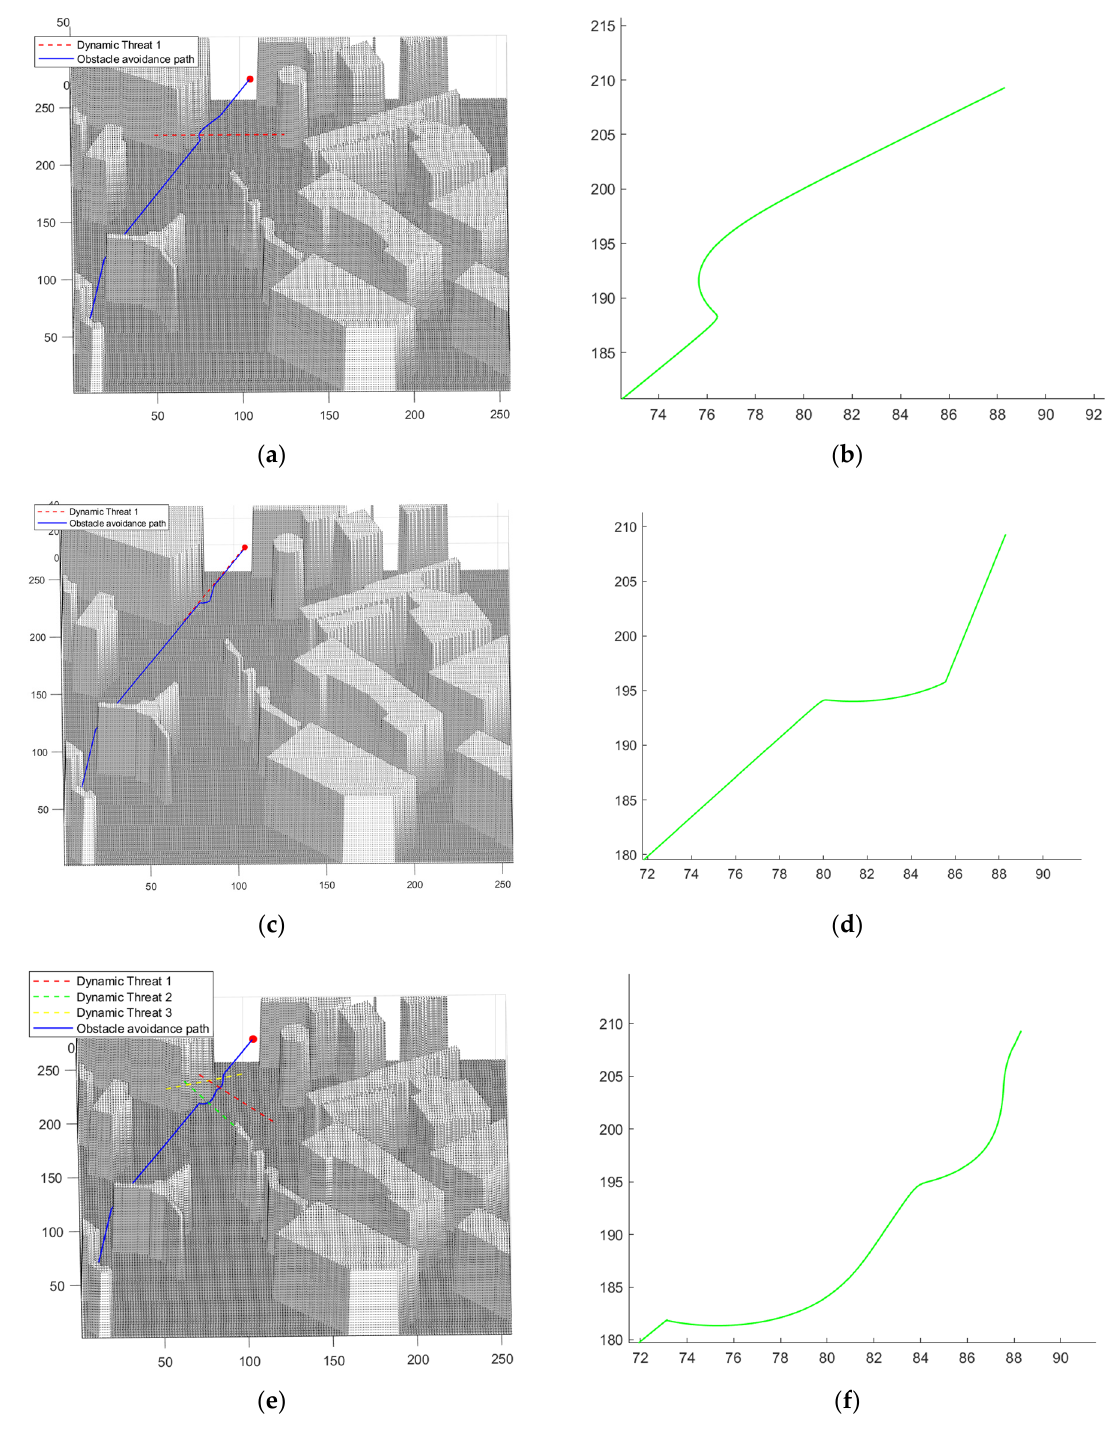
Figure 20. Drone dynamic-obstacle avoidance experiment based on artificial potential field method. ( a ) Single-dynamic-threat avoidance. ( b ) Obstacle avoidance path segments under single dynamic threat based on the artificial potential field approach. ( c ) Same trajectory reverse dynamic threat avoidance. ( d ) Obstacle avoidance path segments under inverse dynamic threat of the same trajectory based on the artificial-potential-field method. ( e ) Multi-dynamic threats avoidance. ( f ) Artificial potential field based approach for obstacle avoidance path segments under multiple dynamic